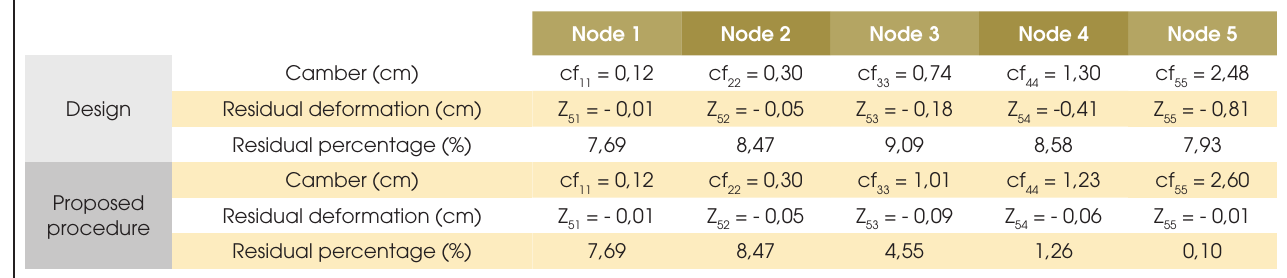
Table 7 – Camber, Residual deformation and Residual percentage to Case